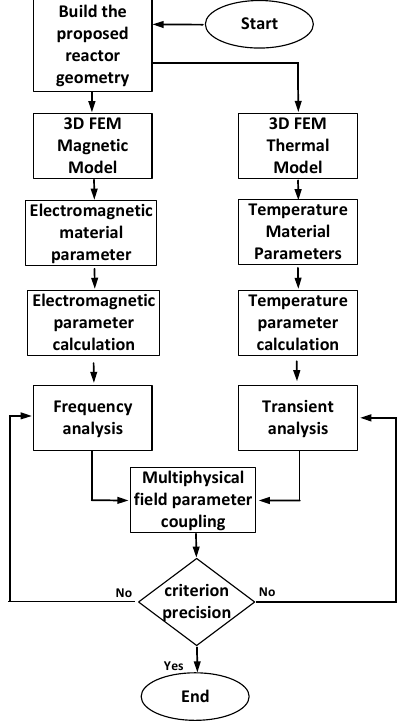
Figure 6. Finite element solution process.